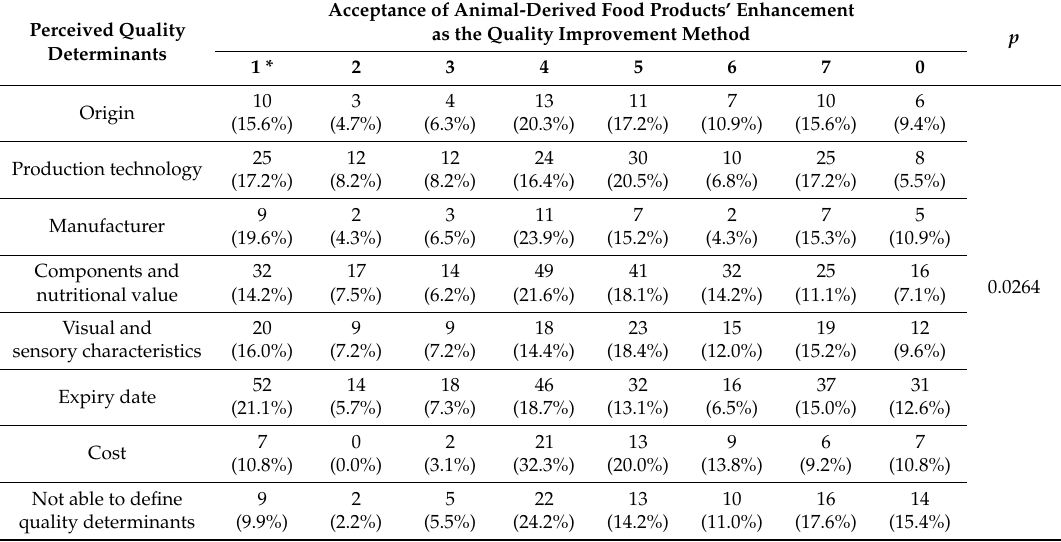
Table 3. Level of acceptance of enhanced animal-derived food products for respondents stratified by perceived quality determinants.